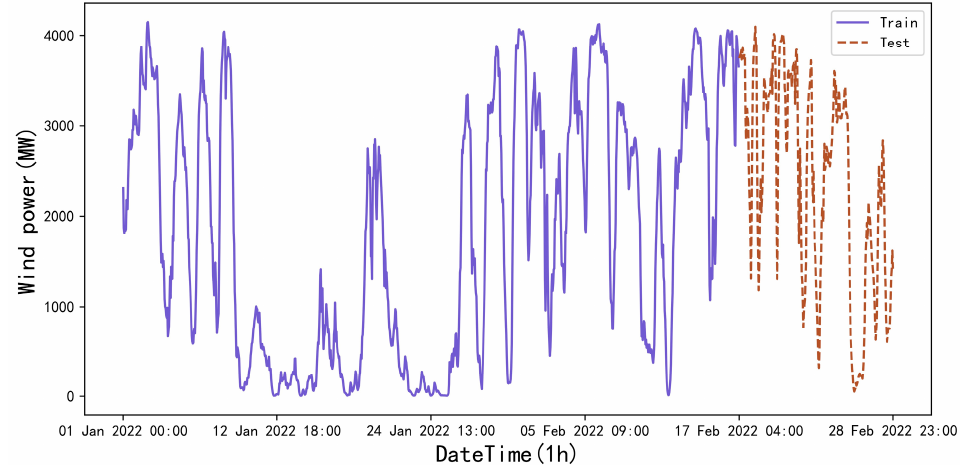
Figure 5. Wind power plot of aggregate Belgian wind farms from 1 January to 28 February 2022. Table 1. The main parameters of the NNMs.